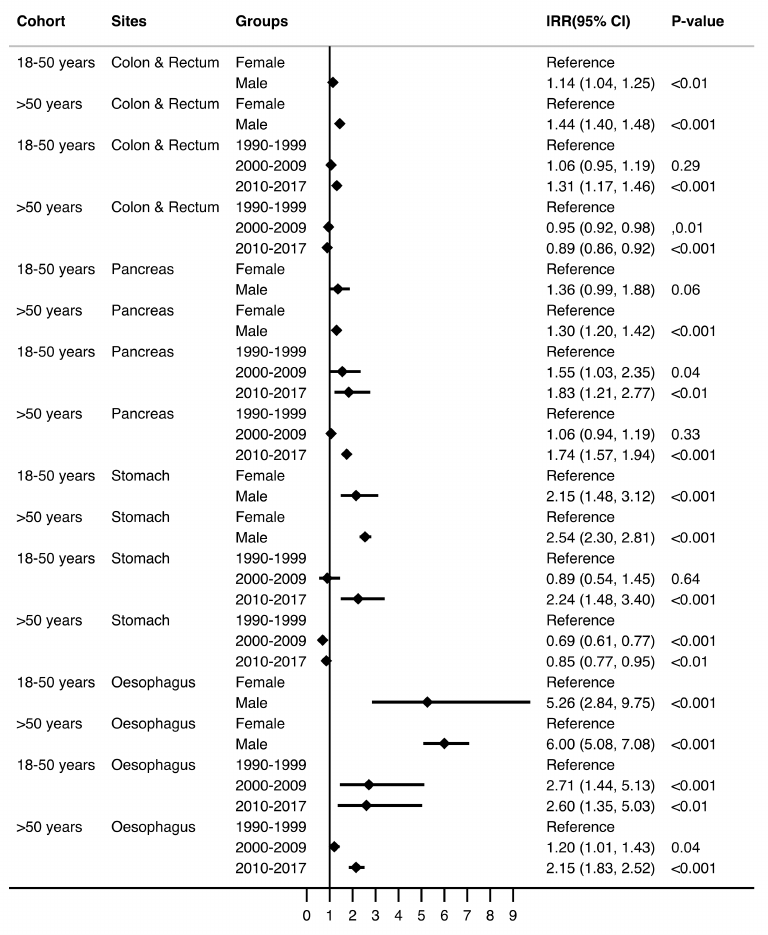
Figure 1. Trend in incidence rates by sex and era between two age groups across cancer sites 1990–2017 ( n = 28,566).